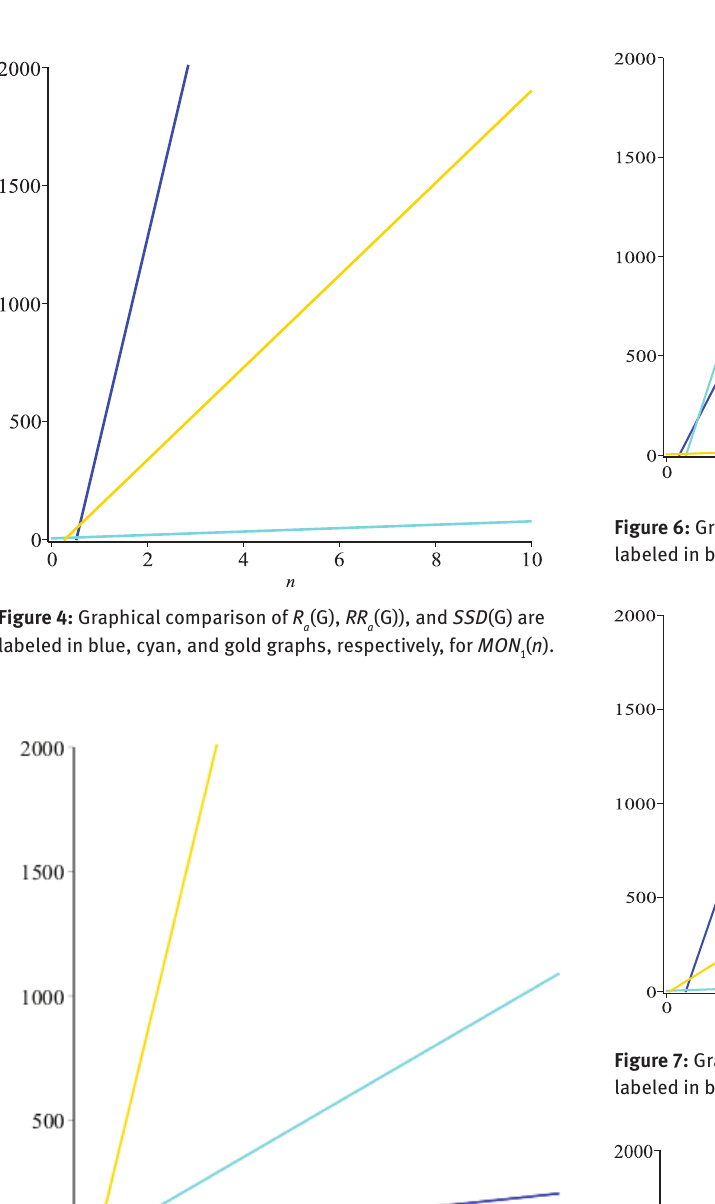
Figure 7: Graphical comparison of R labeled in blue, cyan, and gold graphs, respectively, for MON